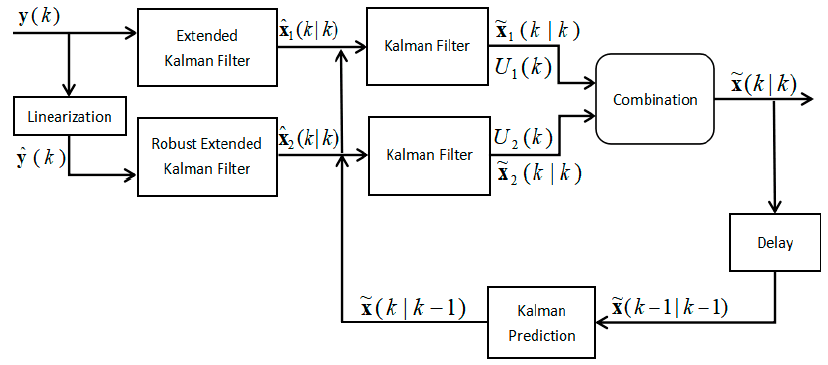
Figure 1. The flowchart for the proposed algorithm.